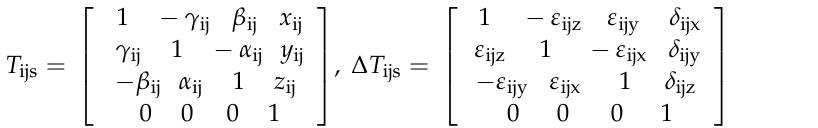
Figure 20. Motion accuracy of each axis. 4.2. Experimental Verification The micro machine tool is composed of two parts: the electrical system and the me- chanical system. The electrical system includes electrical control principle, power supply circuit of each control unit, selection of the numerical control system and application of the servo control method. The mechanical system mainly includes processing of non-